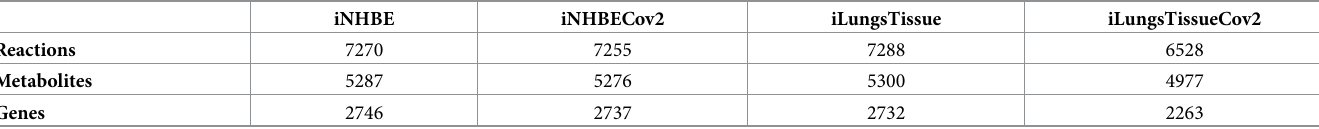
Table 1. Number of reactions, metabolites and genes in each of the model generated for differential flux analysis. iNHBE